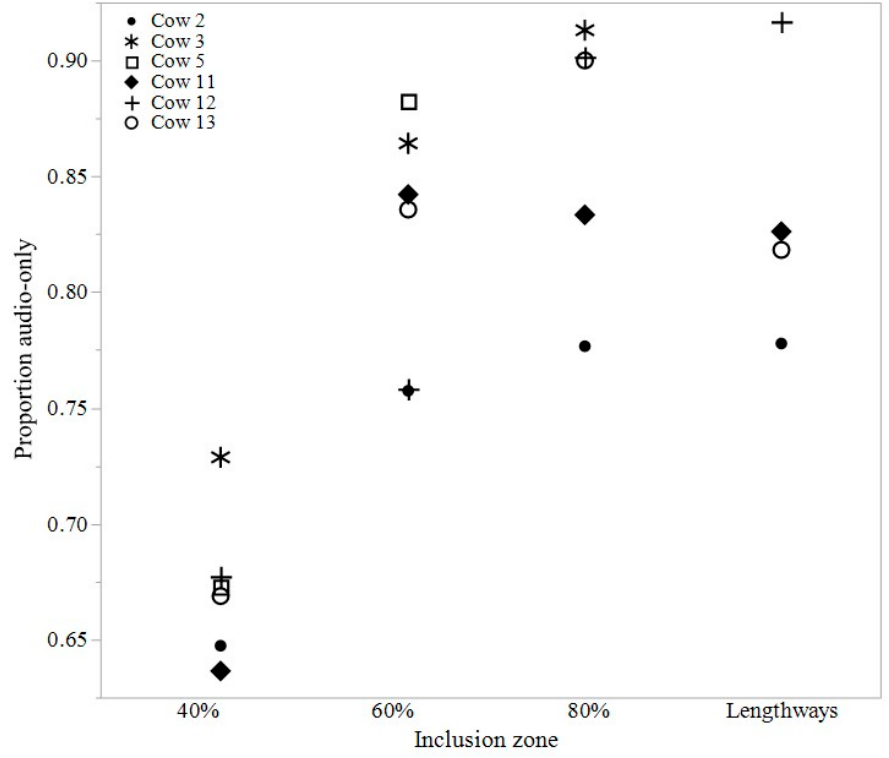
Figure 3. The proportion of audio-only stimuli for individual cattle within each of the four sequential inclusion zones located in a single test paddock. The 40% inclusion zone included the initial period of animal learning. Data from six cattle were recorded during the 40% and 60% inclusion zones, but due to collar malfunction, data were only recorded from n = 5 cows during the 80% fence period and from n = 4 cows during the lengthways period; collars were functional and kept the animals within the inclusion zones but did not log data.